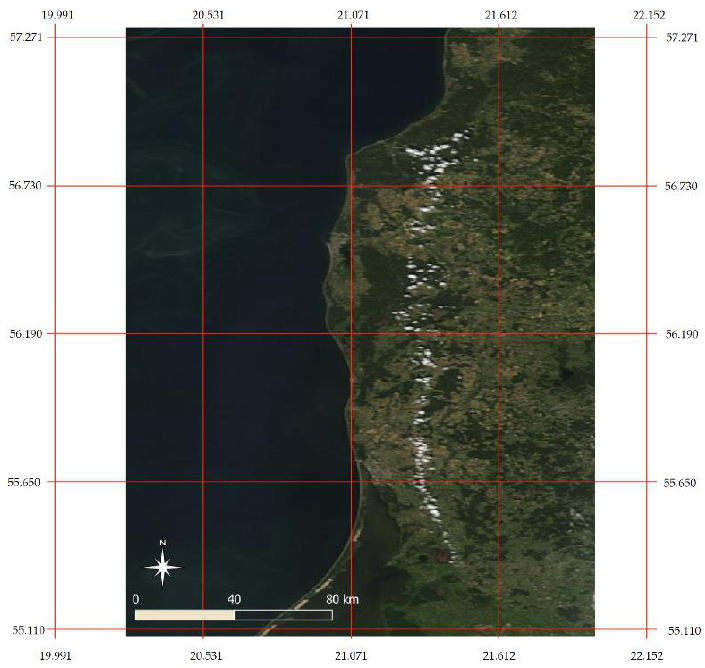
Figure 4. Meteosat-10 satellite images. 23 July 2018, 13:30 (GMT+2).